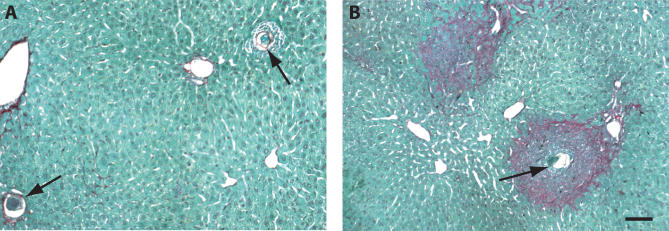
Late Treatment of S. mansoni–Infected Mice with K11777 Decreases the Granulomatous Reaction to Parasite Eggs Trapped in the LiverAfter necropsy of mice from experiments outlined in Figure 1, livers were sectioned at 5 μm and stained with hematoxylin and eosin. Arrows in representative sections indicate schistosome eggs; the granulomatous reaction to the eggs is much reduced after the late-treatment regimen (A), compared to the intense reaction visible in sections from untreated control mice (B). Note that after early K11777 treatment, eggs or egg-associated granulomas were not found (unpublished data). Scale bar = 100 μm.